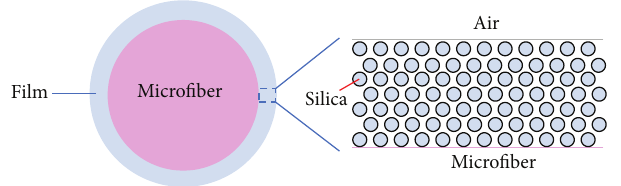
Figure 1: Structure of microfiber with nanoscale-structured film.